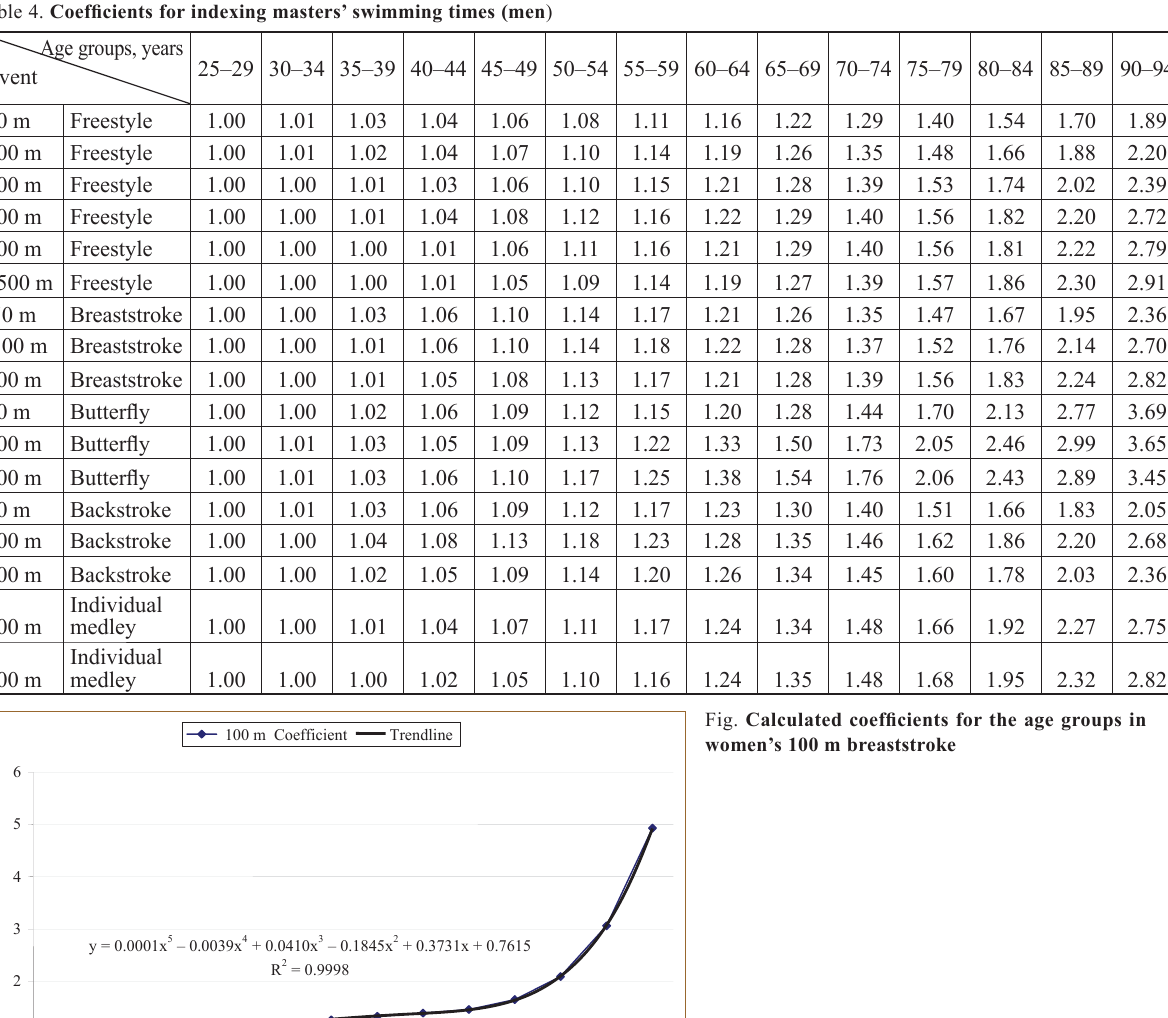
Fig. Calculated coef fi cients for the age groups in women’s 100 m